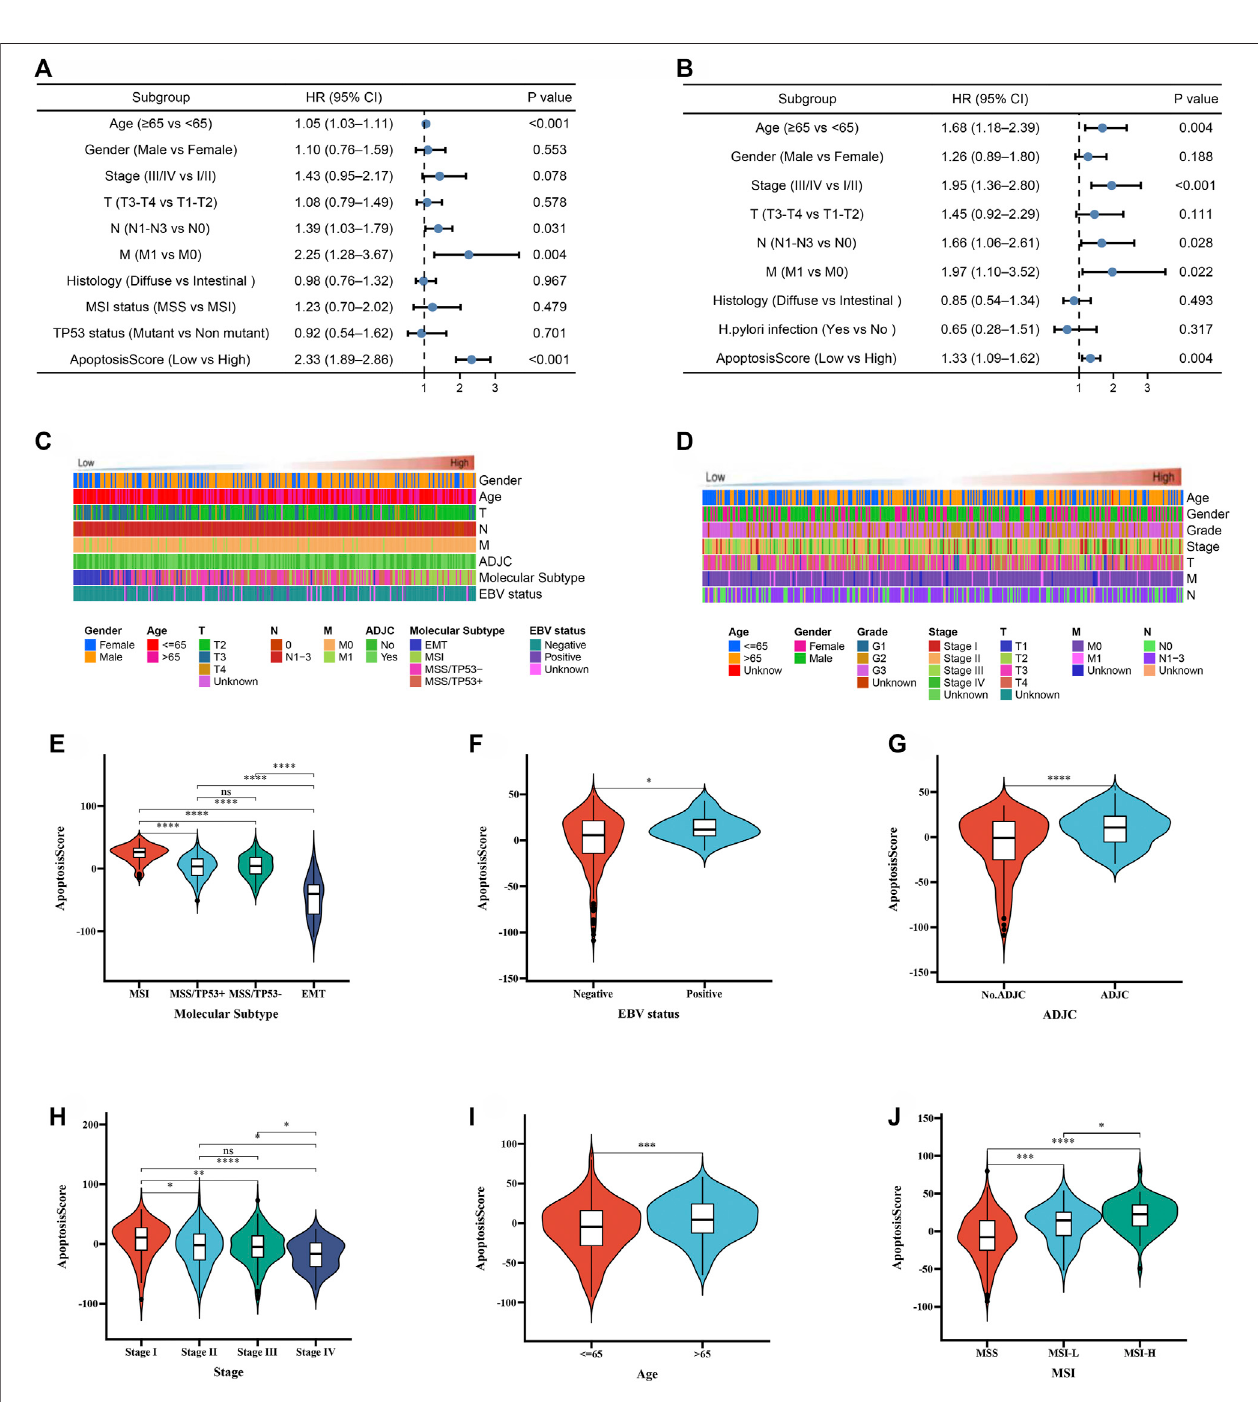
FIGURE 6 | The prognostic value of apoptosisScore in GC patients. (A) Multivariate Cox regression analysis for apoptosisScore in ACRG cohort shown by the forest plot. (B) Multivariate Cox regression analysis for apoptosisScore in TCGA cohort shown by the forest plot. (C) Heatmap showing the dependence between apoptosisScore and clinicopathologic characteristics in ACRG cohort. (D) Heatmap showing the dependence between apoptosisScore and clinicopathologic characteristics in TCGA cohort. (E – G) Differences in apoptosisScore between molecular subtypes, EBV status, ADJC status in ACRG cohort. (H – J) Differences in apoptosisScore between stage, age, MSI status in TCGA